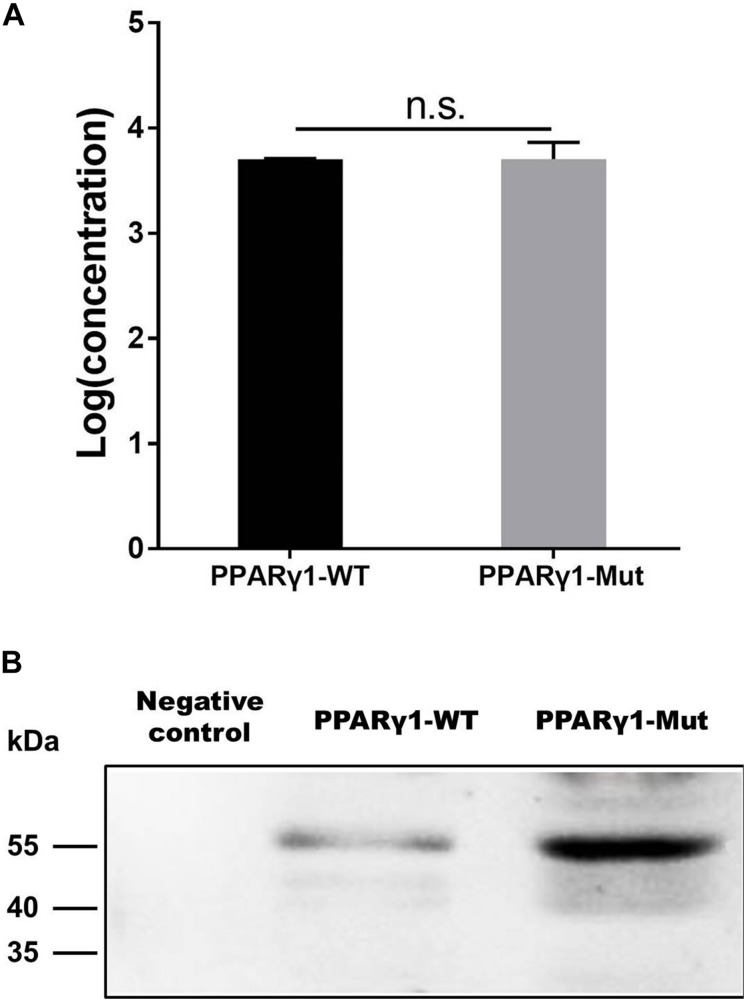
The uORF represses in vitro PPARγ1 translation. (A)
In vitro transcribed PPARγ1 mRNAs from the wild-type and uORF-mutant PPARγ1 expression vectors (pcDNA3.1-PPARγ1-WT and pcDNA3.1-PPARγ1-Mut) were analyzed by quantitative real-time RT-PCR. No difference in PPARγ1 mRNA was observed. Data were expressed as the mean ± SEM, n.s., not significant, Student’s t-test. (B) Equal amounts of the in vitro transcribed mRNAs (2 μg) were used for in vitro translation. Note that the uORF strongly represses PPARγ1 translation. A in vitro translation reaction without RNA template was used as a negative control.